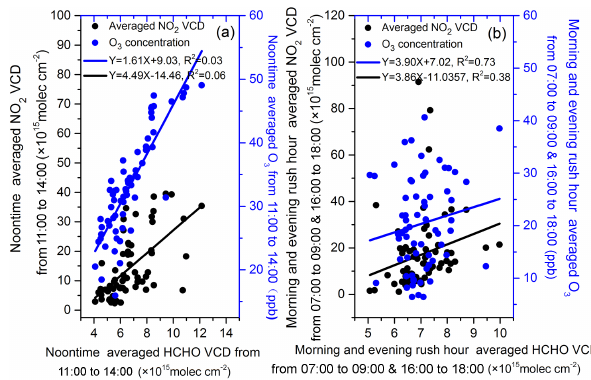
Figure 14. Scatter plots and linear regressions (a) of noontime av- erage HCHO VCD measured by MAX-DOAS against O 3 VMRs measured by a stationary ozone monitoring instrument and (b) of rush hour average HCHO VCD against NO 2 VCD measured by MAX-DOAS from October to December